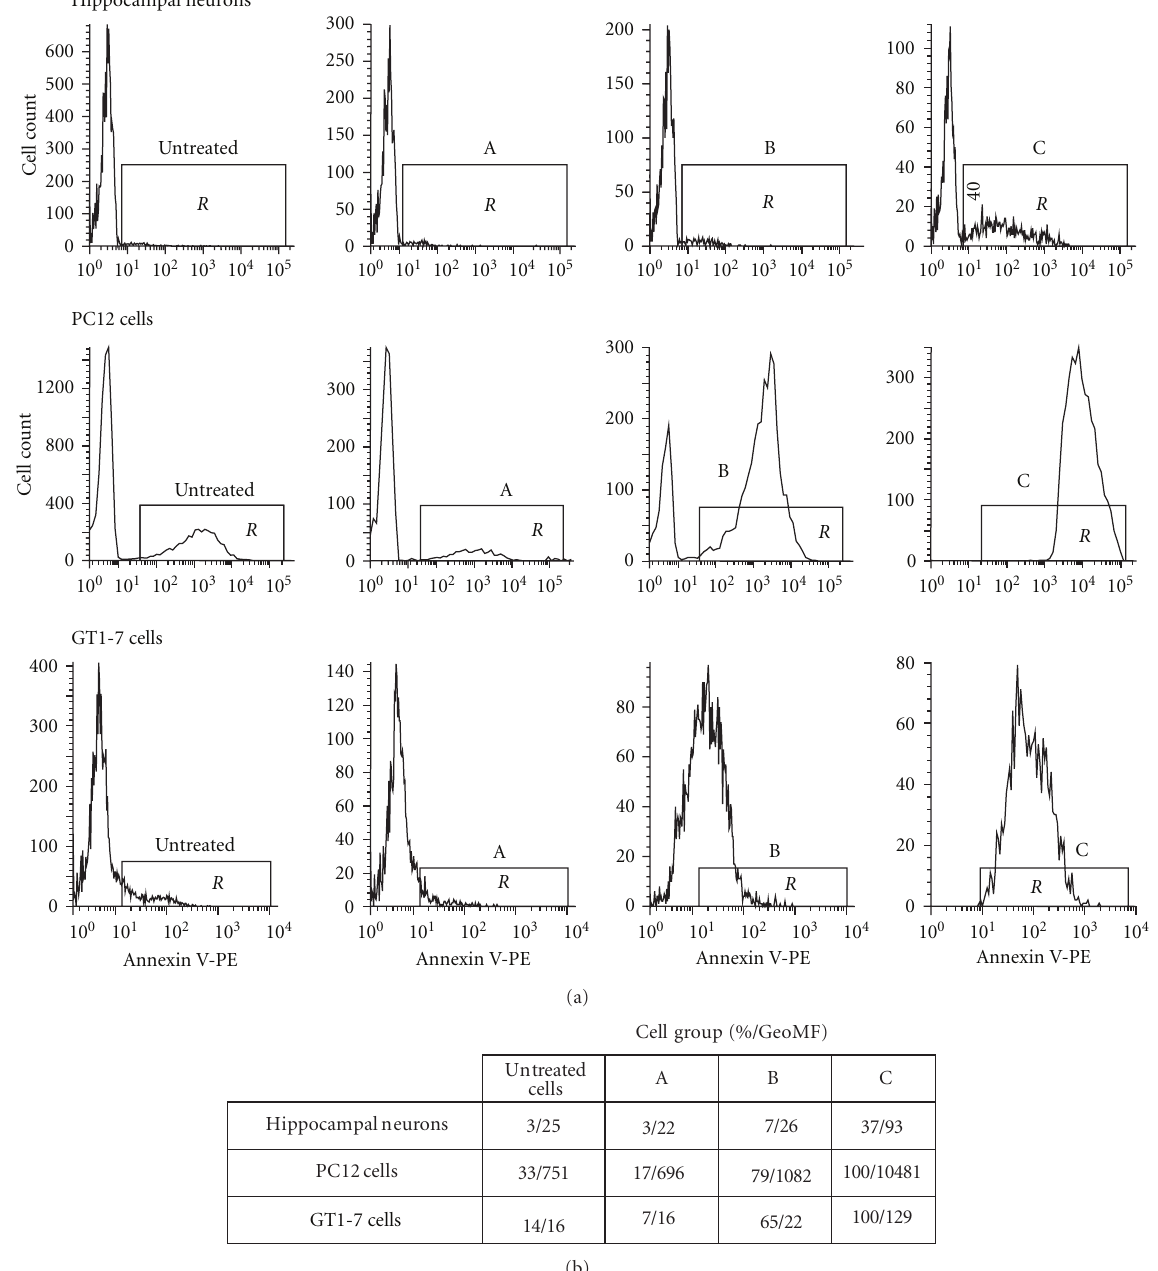
Figure 2: Correlation between A β -FAM binding and the levels of surface phosphatidylserine in di ff erent types of cells. Hippocampal neurons, PC12, and GT1-7 cells were double fluorescence labeled with A β -FAM and annexin V-PE. The histograms show fluorescence analysis from the three types of cells based on levels of intensity of the cell-bound annexin V-PE of each one of the subpopulations as defined in Figure 1. There is a remarkable correlation between the level of A β -FAM binding and the level of PtdSer. The table below shows representative results in terms of the percentage of cells (%) and the annexin V-PE Geometric-Mean of Fluorescence (GeoMF) in the gate R . gate M . The extra high A β 42-FAM a ffi nity